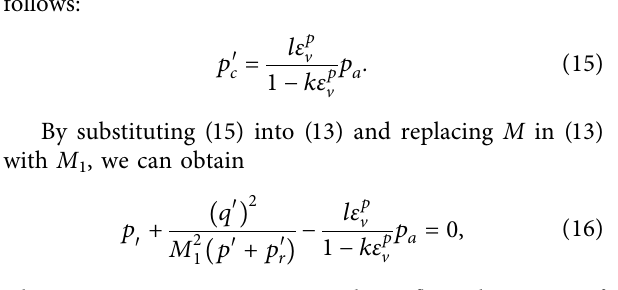
Figure 5: Relation curve ε t v and t under triaxial compression creep